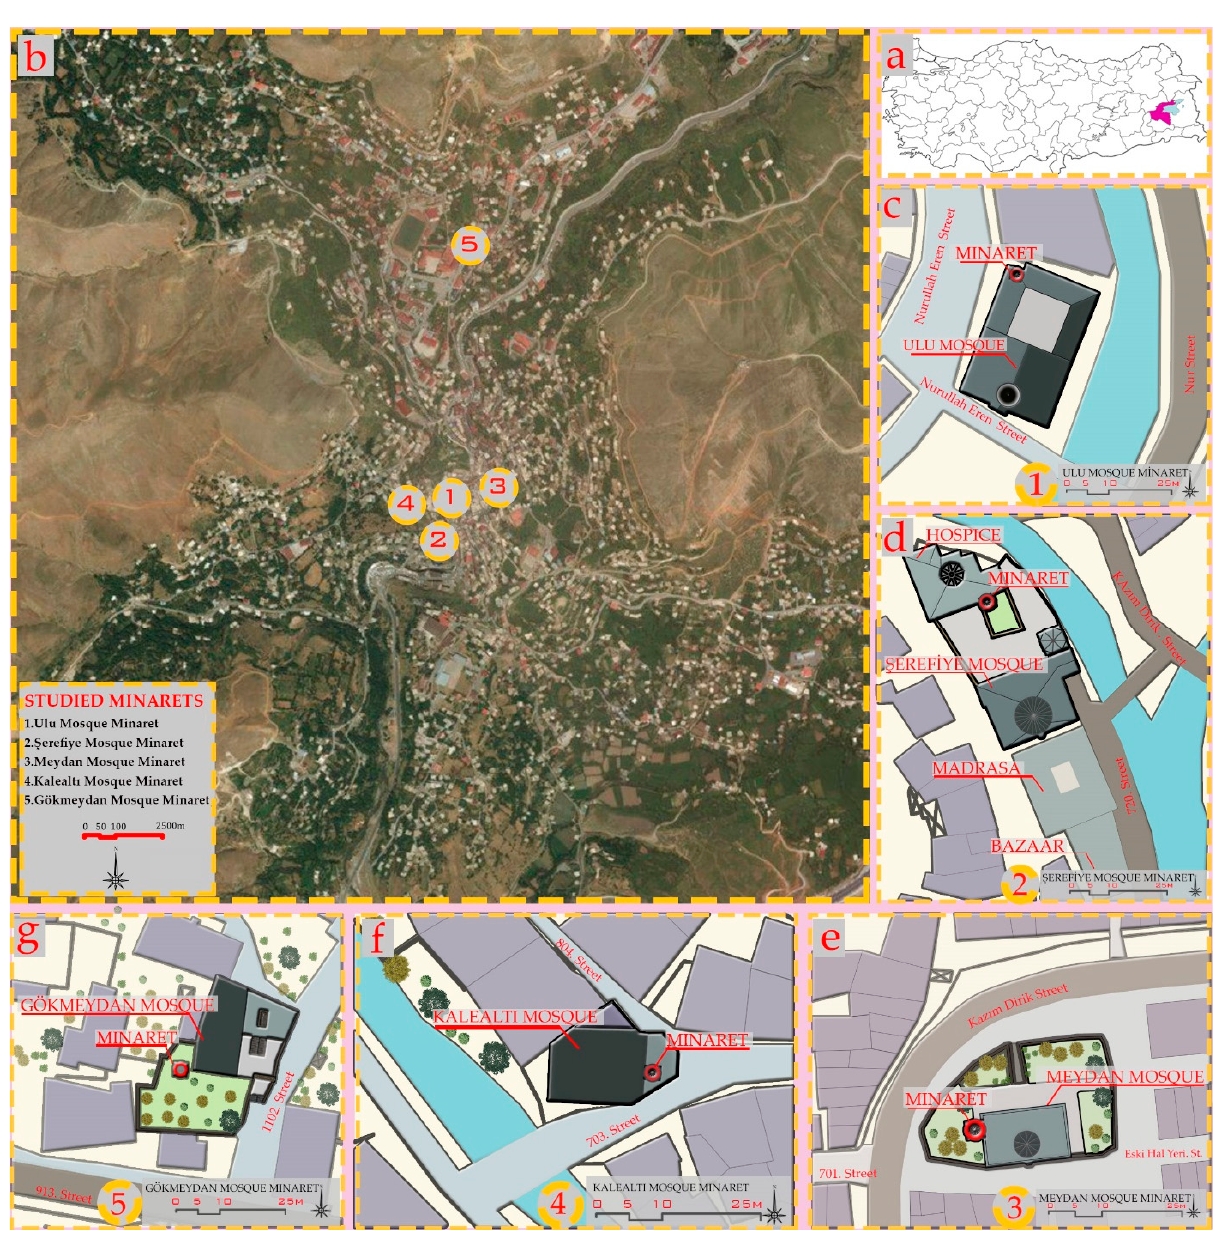
Figure 1. ( a ) The location of the Bitlis city in Turkey. ( b ) The location of Five Minarets in Bitlis city. ( c ) The site plan of the Ulu Mosque and its minaret. ( d ) The site plan of the Ş erefiye Külliye and its minaret. ( e ) The site plan of the Meydan Mosque and its minaret. ( f ) The site plan of the Kalealtı Mosque and its minaret. ( g ) Plan of Gökmeydan Mosque and Minaret.